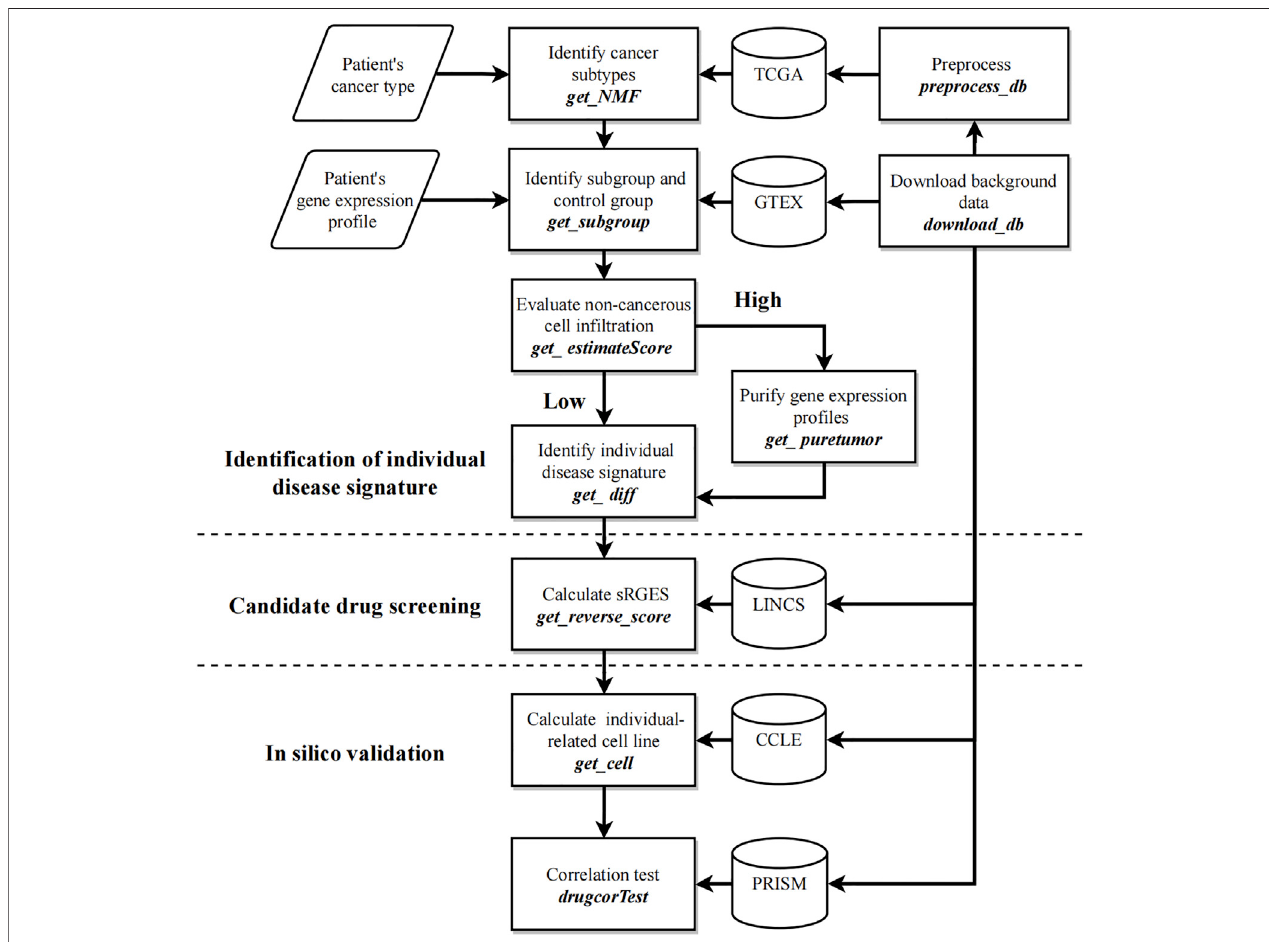
FIGURE 1 | Work fl ow of CPDR. The fl ow diagram shows the user ’ s inputs (parallelogram), the functions (rectangles), and the background data (cylinder). CPDR has two data preparing functions to download and preprocess background data (right functions) and eight analysis functions for identifying an individual disease signature, screening, and validating personalized drugs (left